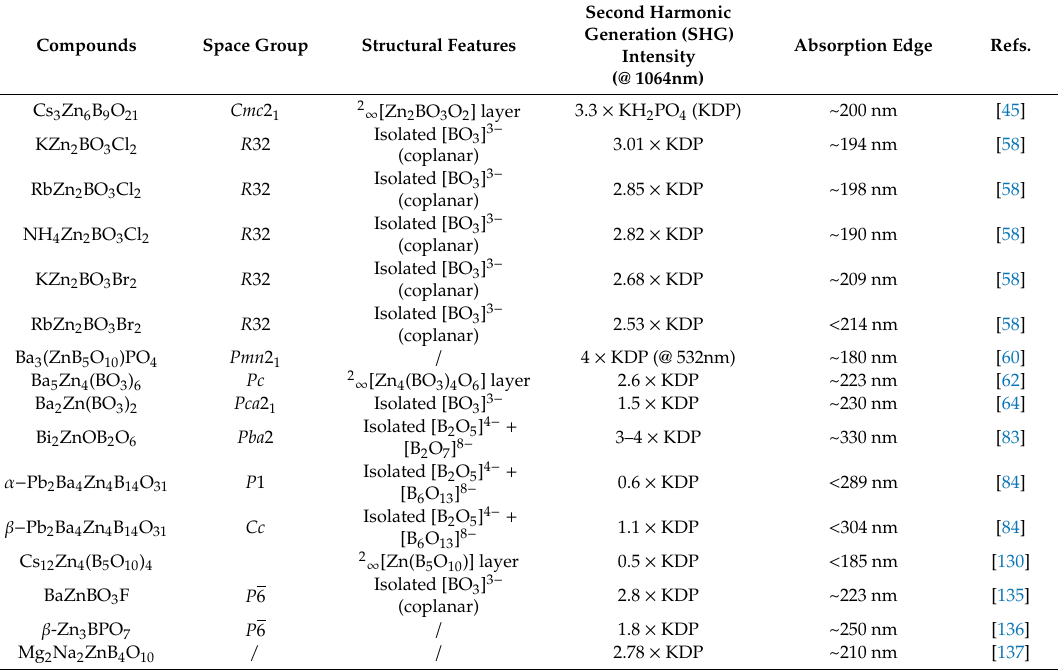
Table 1. The representative non-linear optical (NLO)